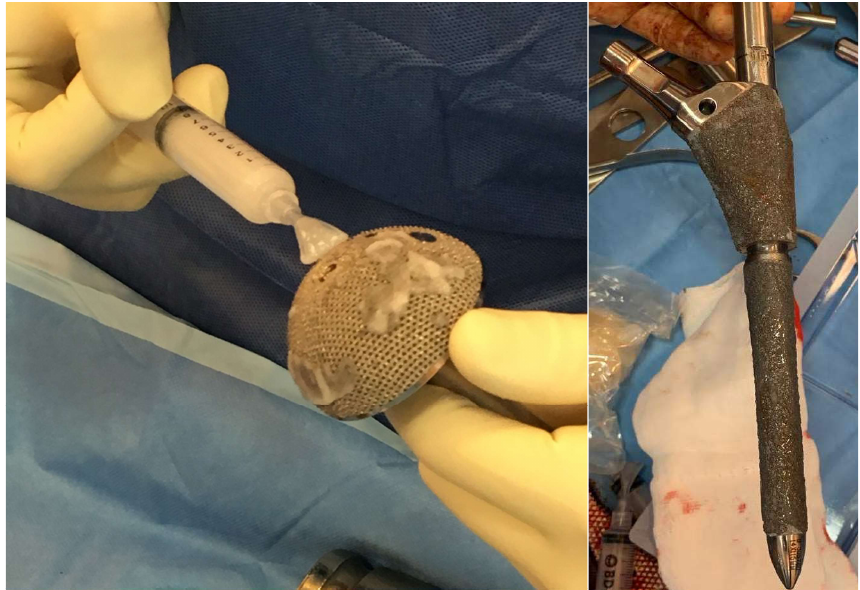
Figure 1. Application of Defensive Antibacterial Coating (DAC) gel on the final implant. 120